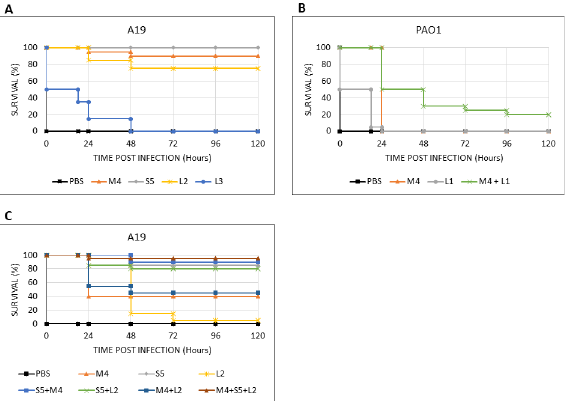
Fig 9. Survival of larvae pre-infected with P . aeruginosa PAO1 and A19 and treated therapeutically with pyocins. G . melonella larvae were infected with 500 CFU of P . aeruginosa A19 or PAO1 and treated with pyocins 3 hours after infection. A– larvaeinfected with A19 strain and treated with 10 μ g of the indicated pyocin. B– larvaeinfected with PAO1 strain and treated with 10 μ g of the indicatedpyocin. C– larvaeinfected with A19 strain and treated with 1 μ g of the indicatedpyocin. Killingcurves were plotted and estimationof differences in survival analyzedby the Kaplan-Meier method using XLSTAT